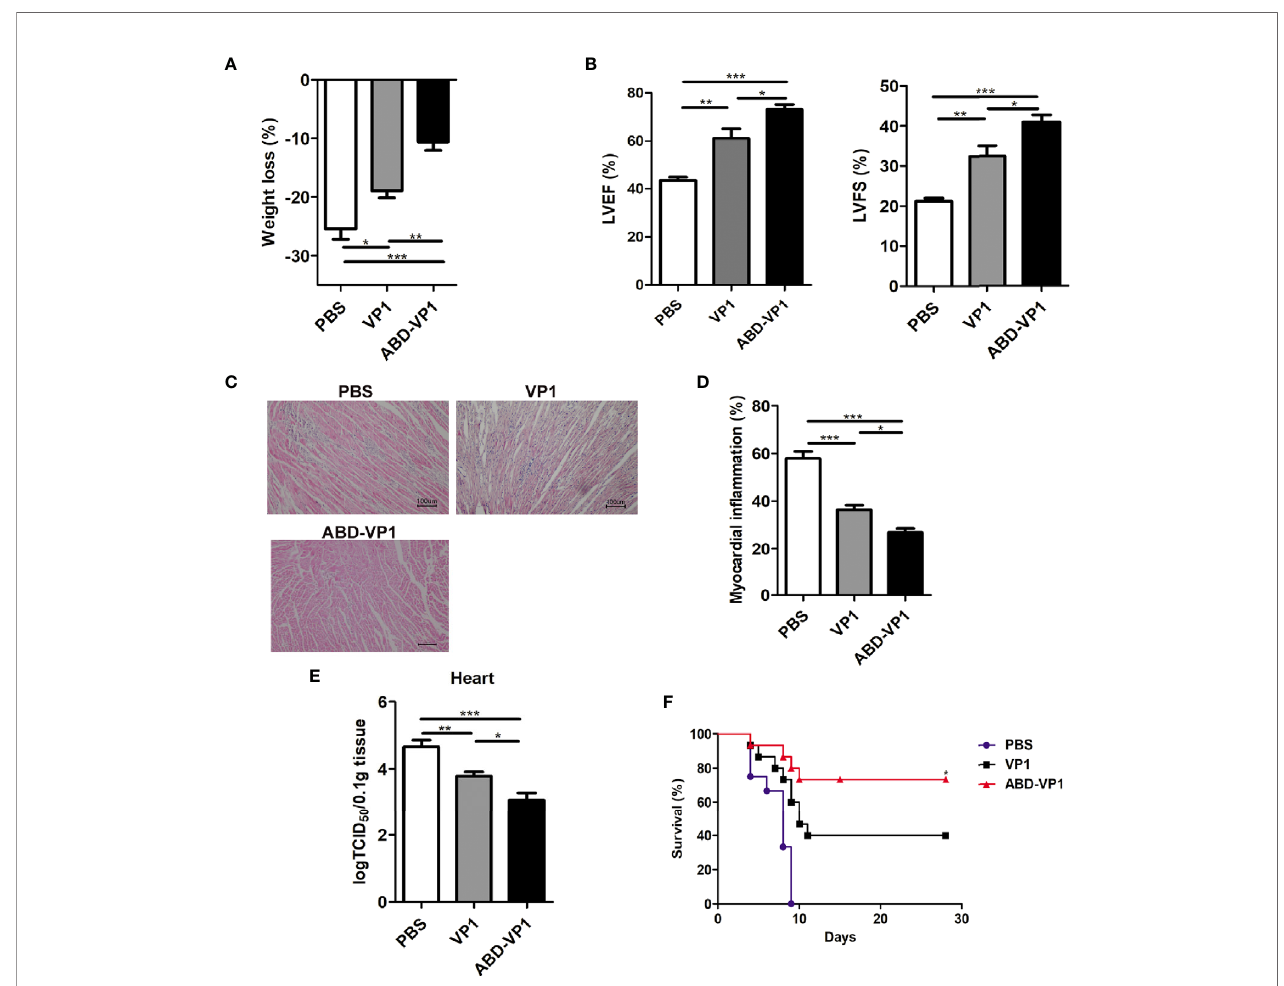
FIGURE 5 | Enhanced immunoprotection against viral myocarditis induced by ABD-VP1 vaccine. Mice were challenged with 3LD 50 CVB3 2 weeks post the fi nal immunization, and myocarditis severity was evaluated 7 days later by (A) body weight loss, (B) cardiac function and (C) histomorphological changes of heart tissues. (D) Statistical analysis of (C) . (E) Meanwhile, viral loads in the hearts were also detected. (F) A 28-day survival rate was observed after 5LD 50 CVB3 infection. *P < 0.05 for VP1 versus ABD-VP1. Each group contained 8 mice. For histomorphological observation, each group contained 6 mice. For survival rate evaluation, each group contained 15 mice. *P < 0.05; **P < 0.01; ***P <